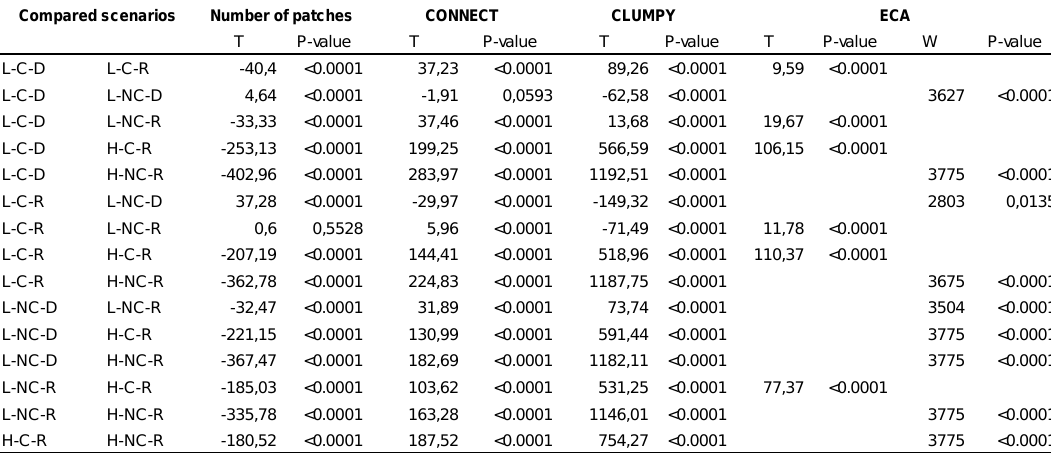
Table A3.2. Statistical results for the comparisons between the indices measuring forest fragmentation (number of patches) and connectivity (CONNECT, CLUMPY, ECA). Scenarios differ in deforestations rate (L: low, H: high), spatial planning at the regional level (C: with corridors, NC: without corridors) and spatial planning at the plot level (D: design, R: